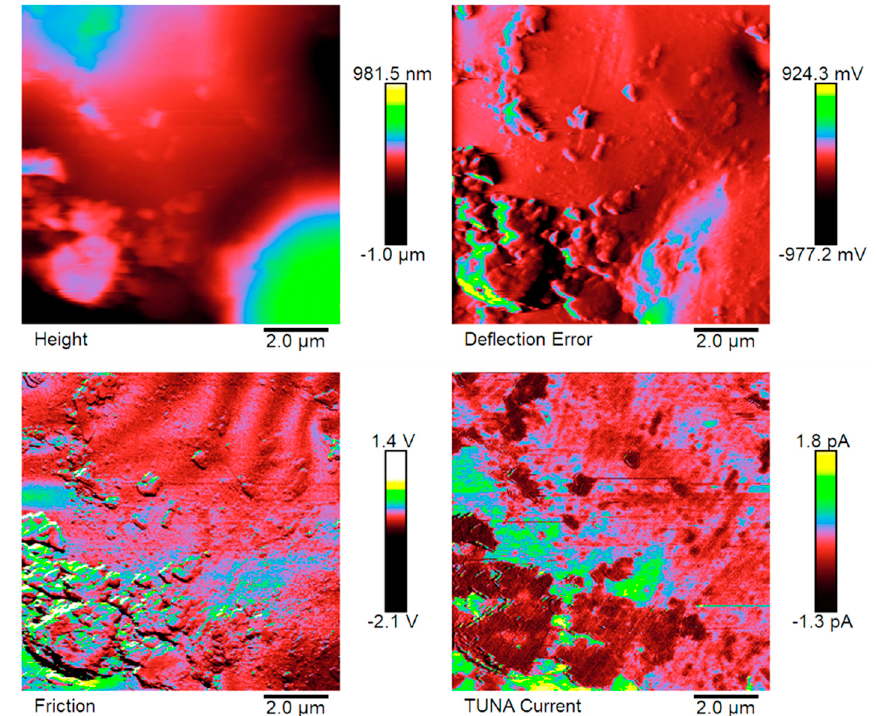
Figure 5. TUNA pictures of the R0.1%G-py fracture surface.